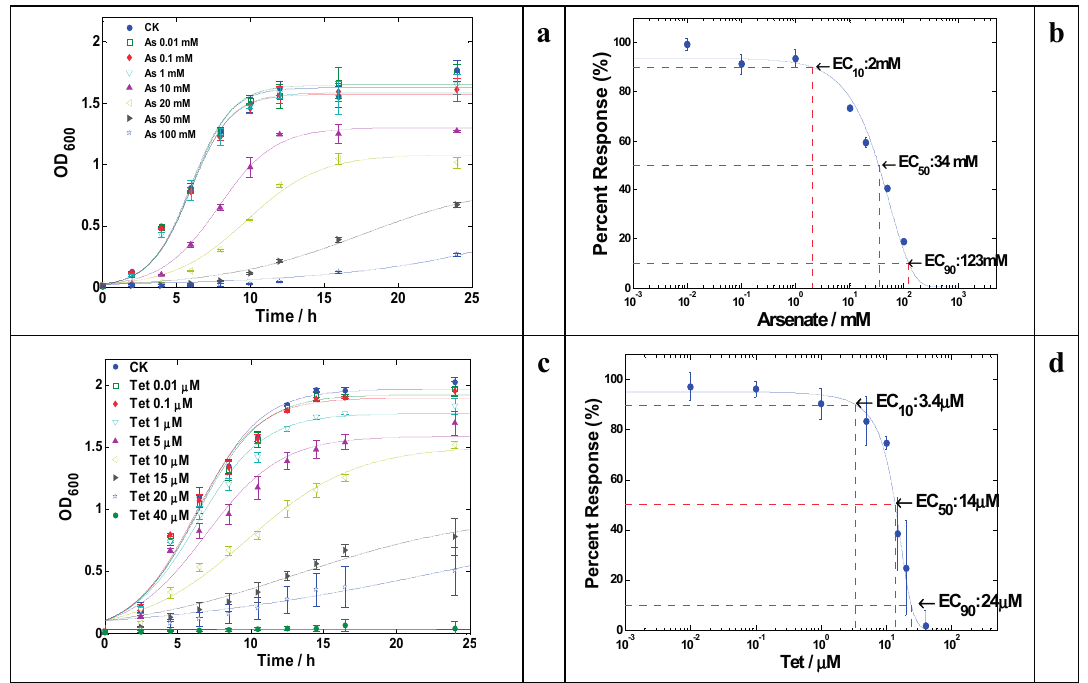
Figure 1. ( a ) Growth curves of LSJC7 with arsenate treatment; ( b ) Dose–response curve of LSJC7 with arsenate treatment; ( c ) Growth curves of LSJC7 with tetracycline treatment; ( d ) Dose–response curve of LSJC7 with tetracycline